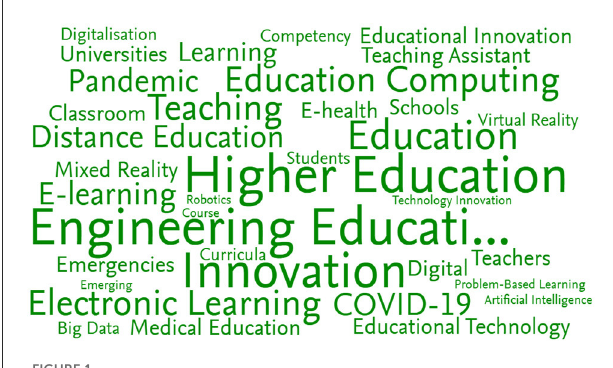
FIGURE1 Keyphrases analysis from Scopus (2022a,b).